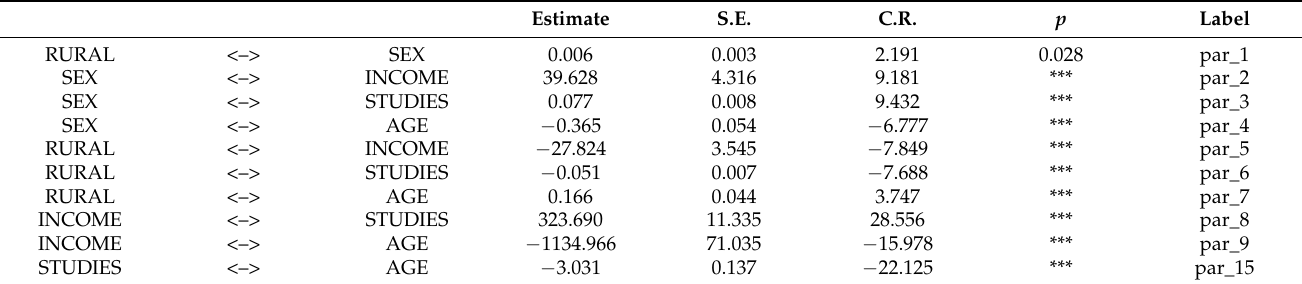
Table A6. Covariances: (Group number 1-Default model).